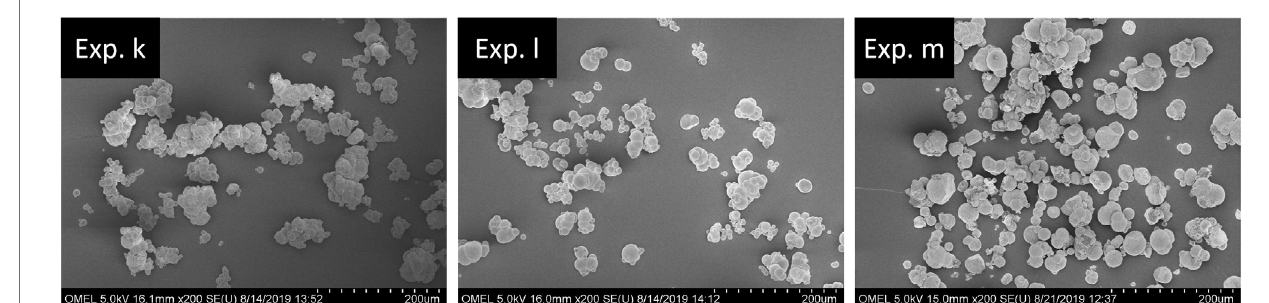
FIGURE 3 | SEM images of the particles collected from reproducibility experiments are shown.